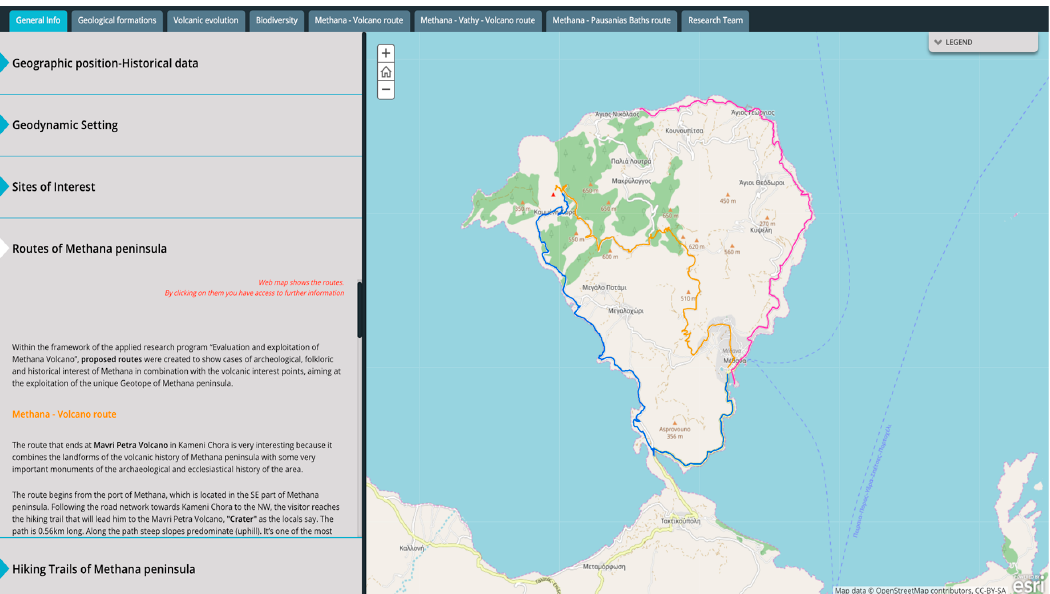
Figure 9. Screenshot of the first tab, where general information for the Methana peninsula is given. Story Map Series—Accordion layout is used, and its fourth tab presents the main paths of the Methana peninsula (https://goo.gl/UR1a9k).